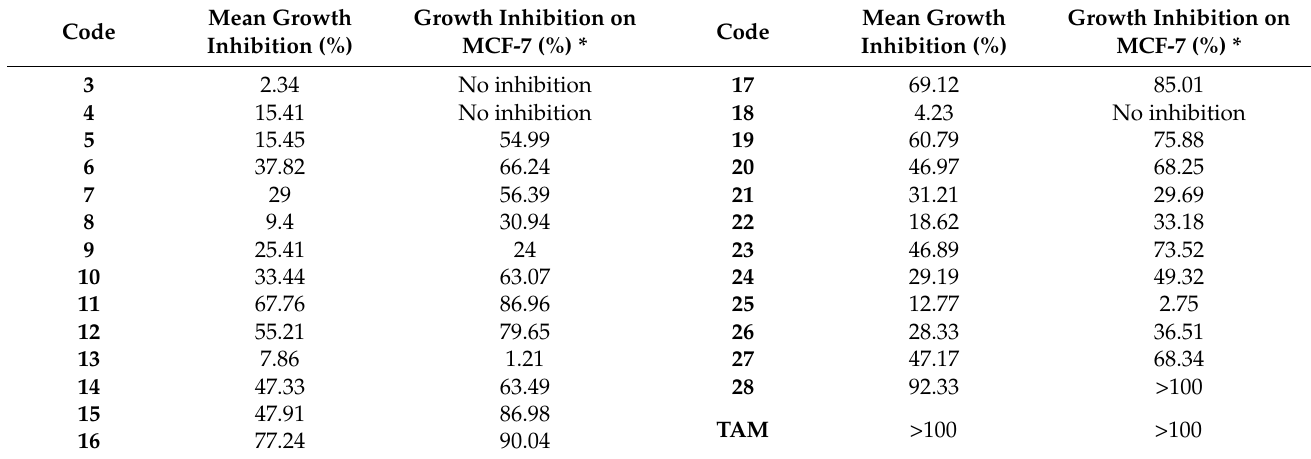
Table 5. Percent mean growth inhibition on 60 NCI tumor cell lines and on MCF-7